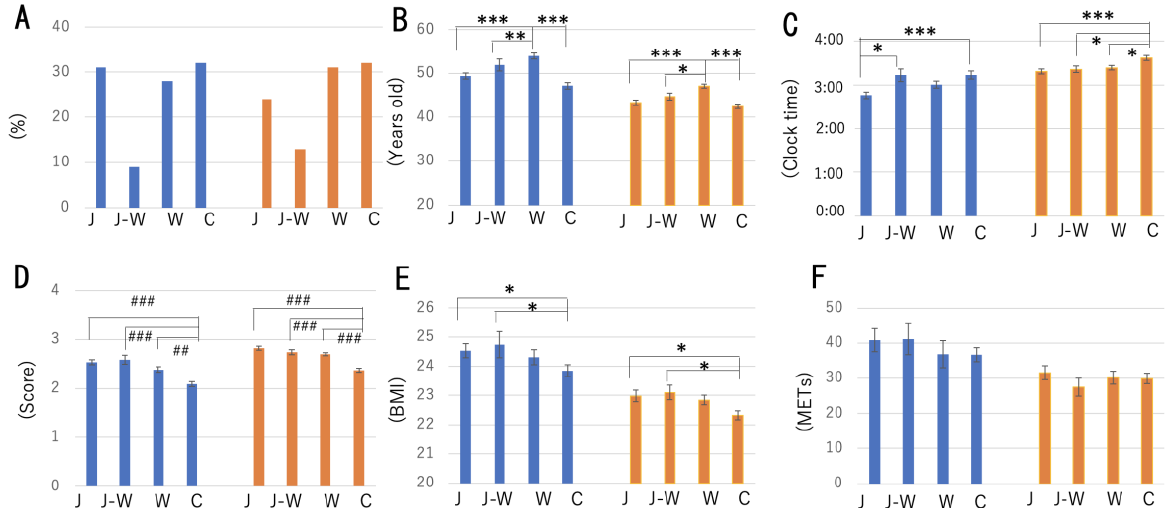
Figure 1. Interaction between various parameters and breakfast meal category. ( A ) Preferences for each meal category. Associations between age ( B ), MSFsc (chronotype) ( C ), eating period ( D ), BMI ( E ), exercise (total METs) ( F ), and meal category. Blue column—male; orange columns—female. Statistical significance was revealed using ANOVA followed by Tukey’s multiple comparison post hoc test: * p < 0.05, ** p < 0.01, *** p < 0.001, or Kruskal–Wallis’s test followed by Dunn’s multiple comparison post hoc test: ## p < 0.01, ### p < 0.001. J—Japanese meal; J-W—Japanese and Western meals;